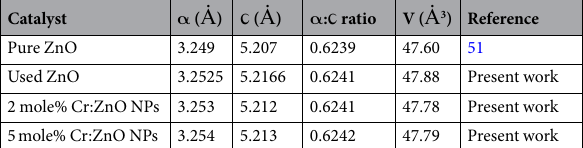
Table 1. Cell parameters of Cr:ZnO NPs.